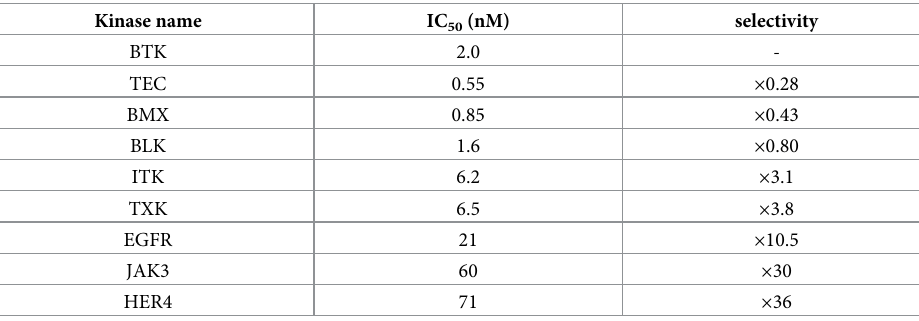
Table 1. Potency and selectivity of TAS5315 in enzymatic